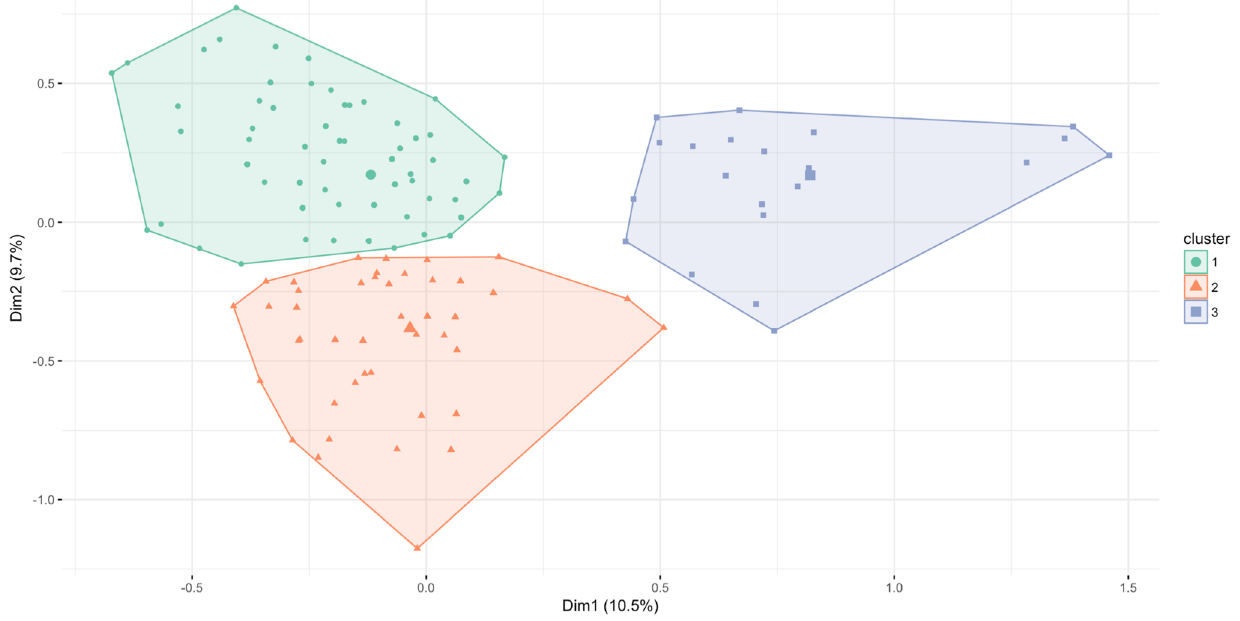
Figure 2. The three clusters of participants identified on the basis of the first two dimensions of the multiple correspondence analysis. Note. The three clusters can be distinguished by the color and shapes of the points: Green cluster = circles; Red cluster = triangles; Purple cluster =